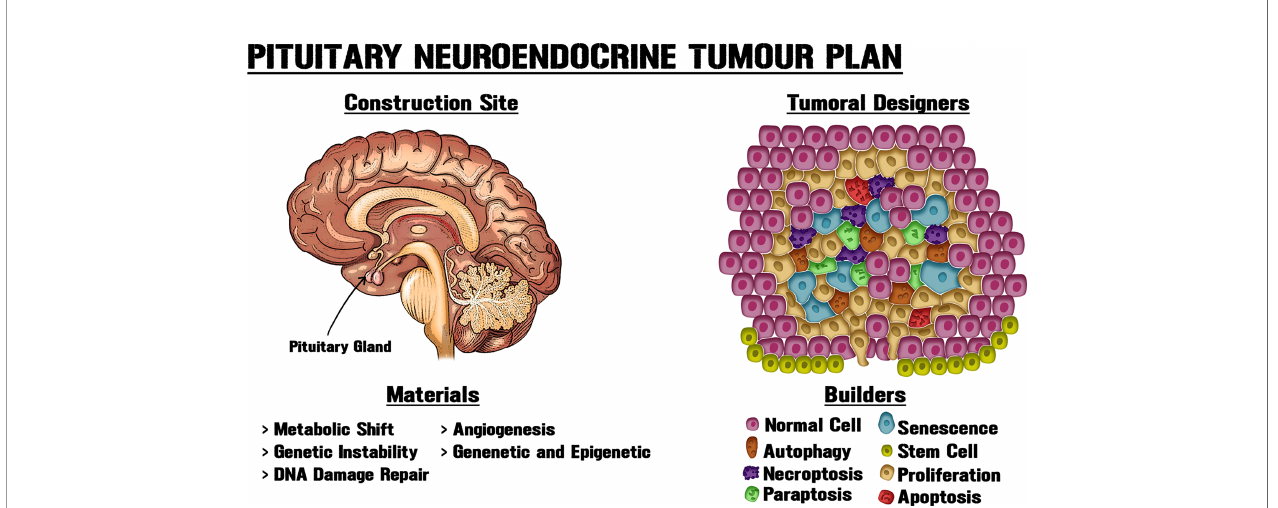
FIGURE 1 | New approaches for pituitary tumorigenic models. PitNETs can display intrinsic heterogeneity and cell subpopulations with diverse biological, genetic and epigenetic particularities, including tumorigenic potential. Tissue architecture and microenvironment could play vital roles in neoplasms. Like an architect who determines the use of materials at a building site, different cellular processes modify the structure and interactions within the gland, thereby shaping tumour growth. Obtaining a better understanding of PitNET growth requires new approaches and systematization of the available data through the combination of molecular, genetic and epigenetic data, together with the utilization of morphological, biochemical, physiological and metabolic knowledge about pituitary neoplastic